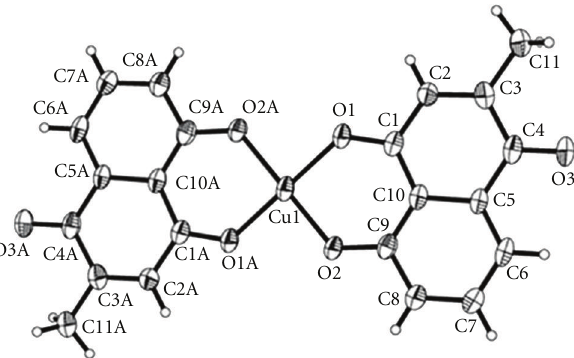
Scheme 2: Crystal structure of plumbagin Cu (II)